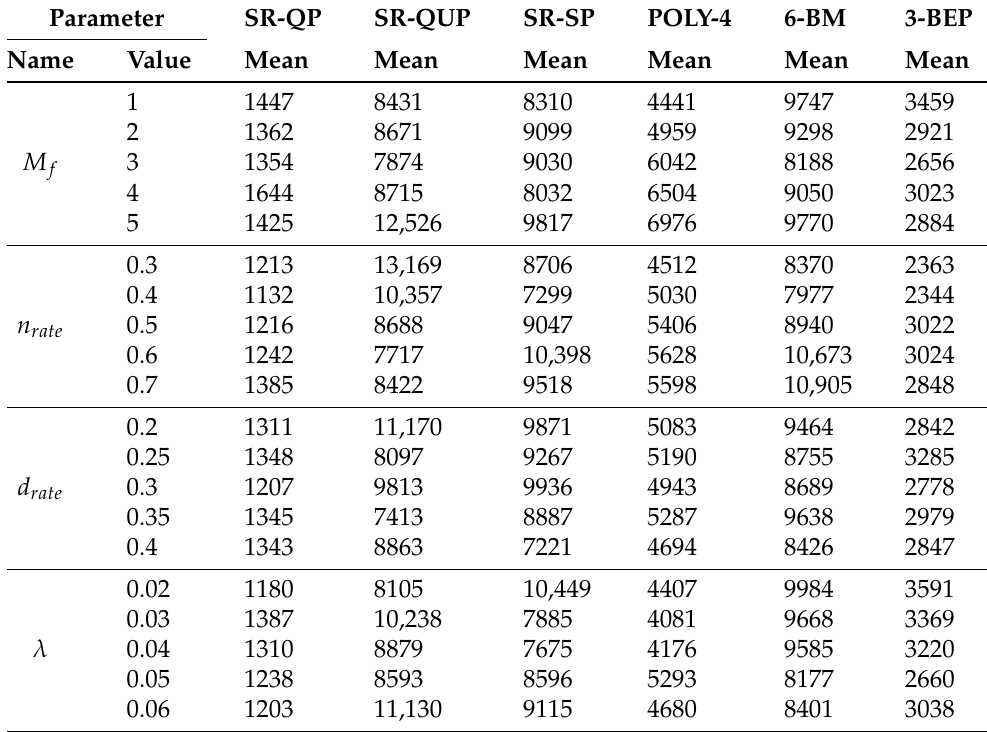
Table 3. ISPLS performance under different values of parameters M f , n rate , d rate and λ